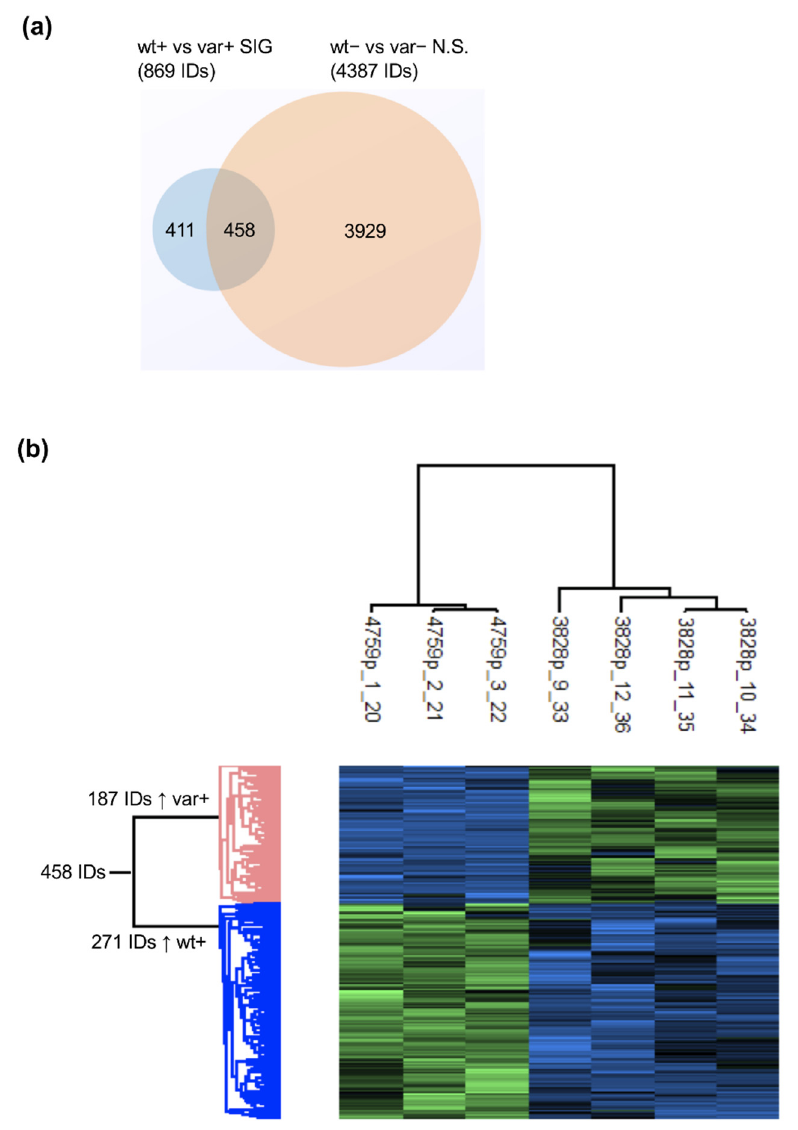
Figure 4. Protein cluster analysis. Cluster analysis of proteins differently expressed between the OSMR H187 patient’s cell line (LY3828, four replicates) and the p.H187Q homozygous patient’s cell line (LY4759, in triplicate) after OSM stimulation is shown. The two samples are referred to as wt+ and var+, respectively. ( a ) The Venn diagram represents the 458 proteins differently expressed between the wt and the var cell lines after OSM treatment (indicated by the “plus sign”) that were not significantly different between wt and var before treatment (“minus sign”); ( b ) the hierarchical analysis showed two clusters clearly visible in the heatmap for these 458 proteins: 187 proteins were overexpressed in var+ compared to wt+ (in blu in the heatmap color-scale), while 271 proteins were overexpressed in wt+ compared to var+ (in green).